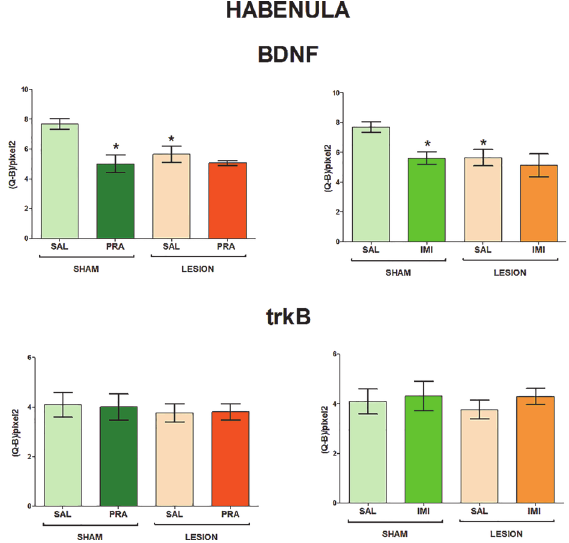
Fig 5. The influence of 6-OHDA, pramipexole and imipramine on BDNF and trkB mRNAs in the habenula. n = 8 – 10. For further explanations see Figs. 1 and 2. doi:10.1371/journal.pone.0117698.g005 BDNF mRNA (pramipexole effect: F[ ] = 3.92, p = 0.057) but decreased trkB mRNA levels 1,27